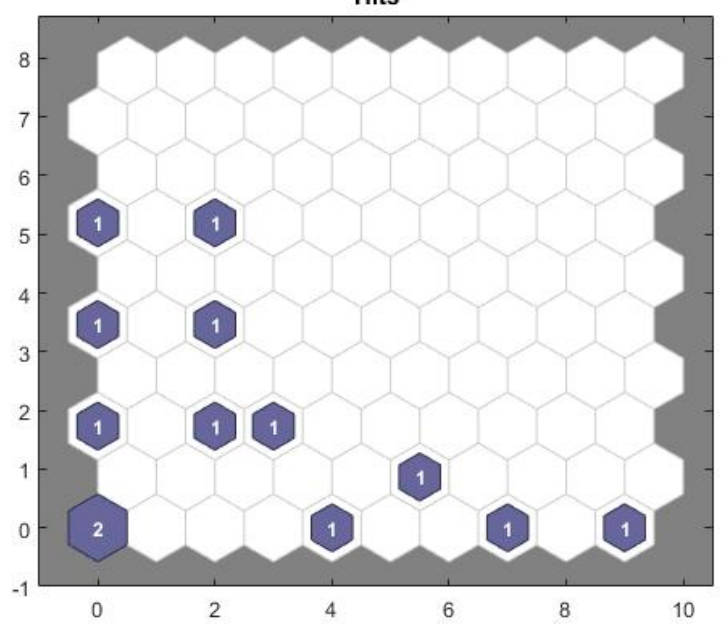
Figure 8. Amount of Hits for Building.